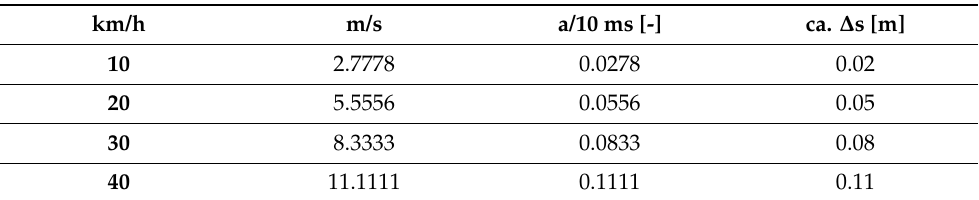
Table 2. The theoretical distance between measuring points of linear acceleration. Source: authors’ own